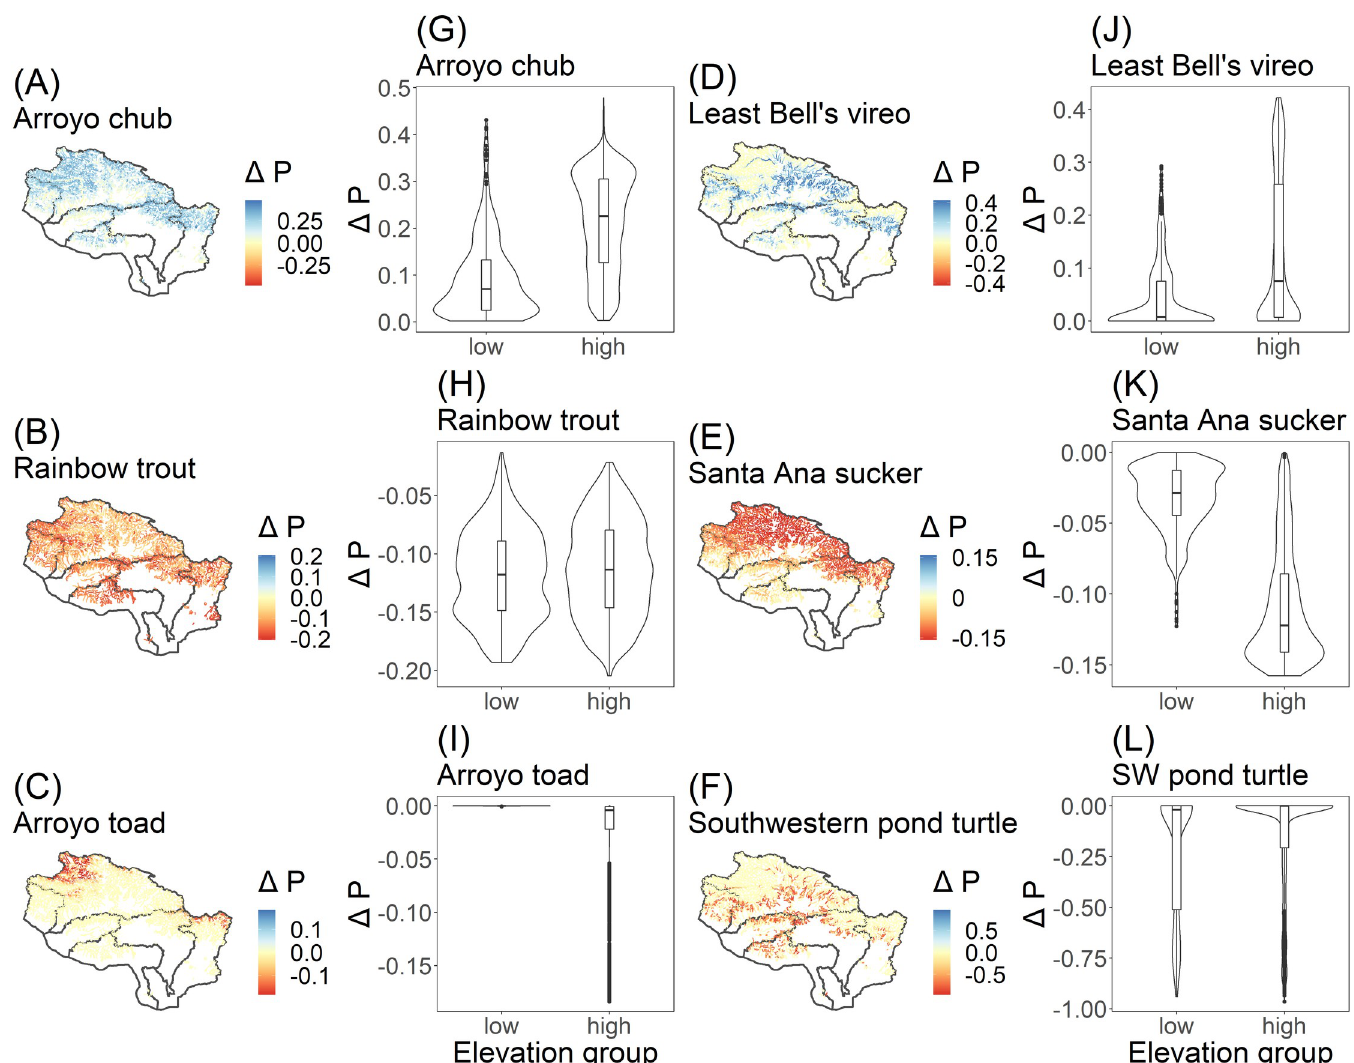
Fig 3. Change in probability of occurrence due to stream temperature. Change was calculated as the average values for each stream reach in the end-of-century minus the average values for each stream reach in the baseline period. A-F show the spatial distribution of the change. Note that between species, the color scale is the same (i.e. blue is a positive change and red is a negative change), but the range of values is different. G-L show the distribution of the change in probabilities for the stream reaches between high and low elevations, which is defined as 375m and higher. Note that the y-axis limits are different for each